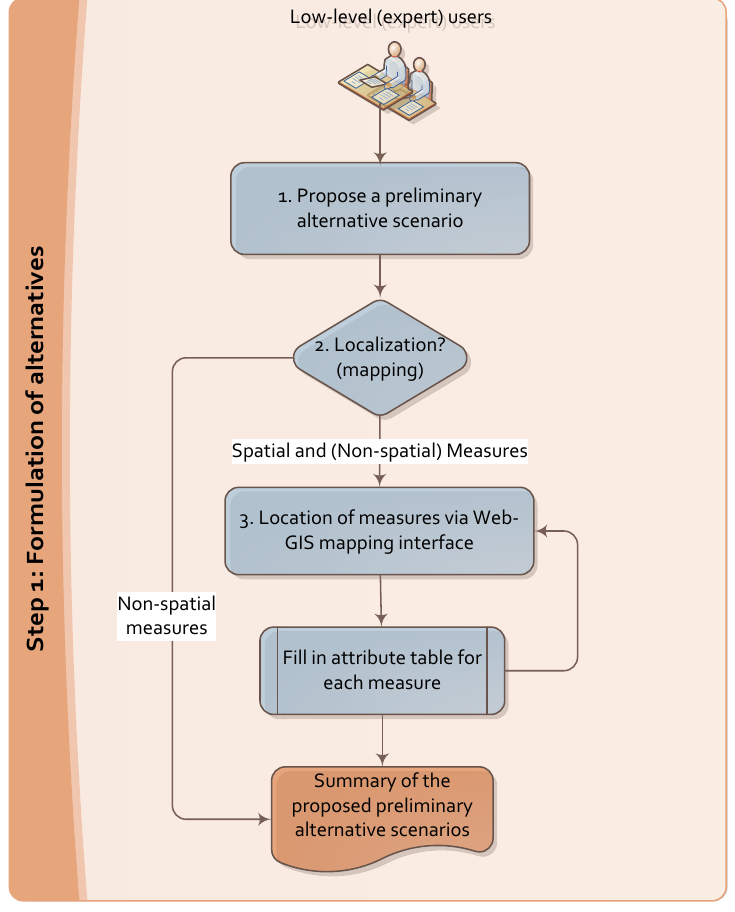
Figure 2. Process flow of the definition of a new alternative